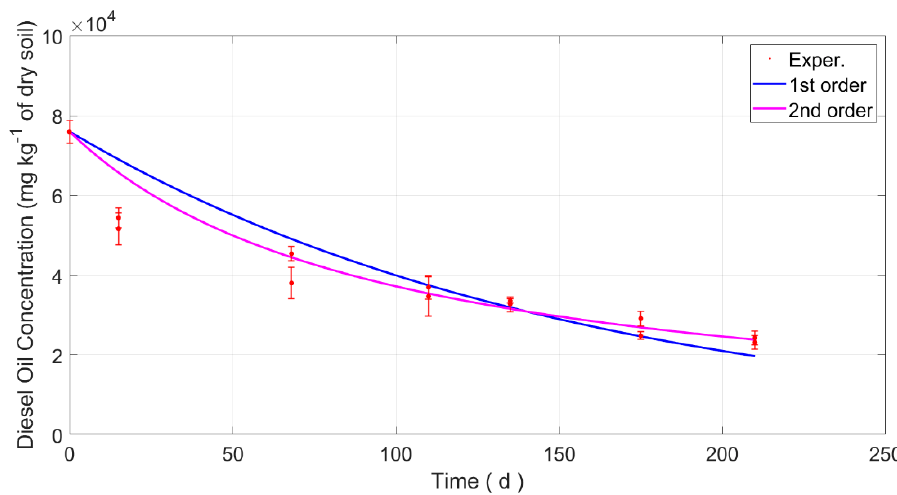
Figure 9. Kinetic modelling for the BIOS and BIOS-G microcosms.